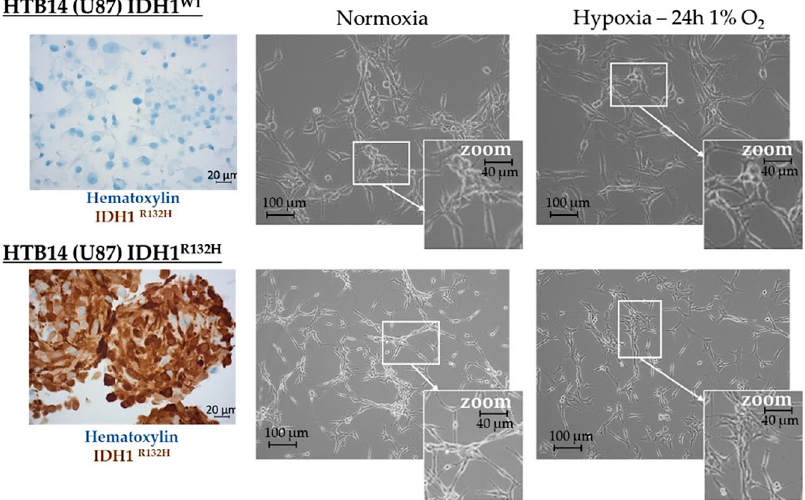
Figure 1. Expression of pro-angiogenic or pro-hypoxic miRNAs according to the presence (HBT-14 (U-87 MG) IDH1 R132H cells) or absence (HBT-14 (U-87 MG) IDH1 WT cells) of the IDH1 R132H muta- tion. The miRNAs were extracted from cell lines using miRNAeasy (Qiagen™), then retrotran- scribed (RT) and amplified (PCR) using the TaqMan MiRNA Reverse transcription kit (Applied Bi- osystem). The RT-PCR data were normalized to the small nucleolar house-keeping RNA, RNA RNU48 (SNORD48) (assay ID 001006). Each miRNA was expressed in base 100 (100 being attributed to the delta-CT of the miRNA measured in HBT-14 (U-87 MG) IDH1 WT cells) ( n = 3, ANOVA fol- lowed by a post hoc Dunnett’s test, *: p < 0.05, **: p < 0.01). The mir-126-5p was undetectable in these lines.